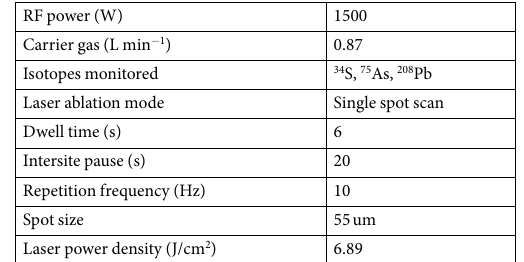
Table 1. Instrumental parameters using an ICP-MS and laser ablation system.